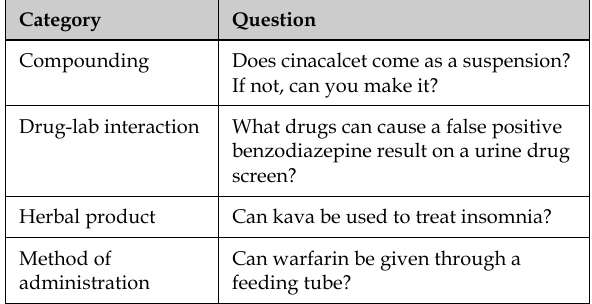
Table 2 Drug information categories and questions used